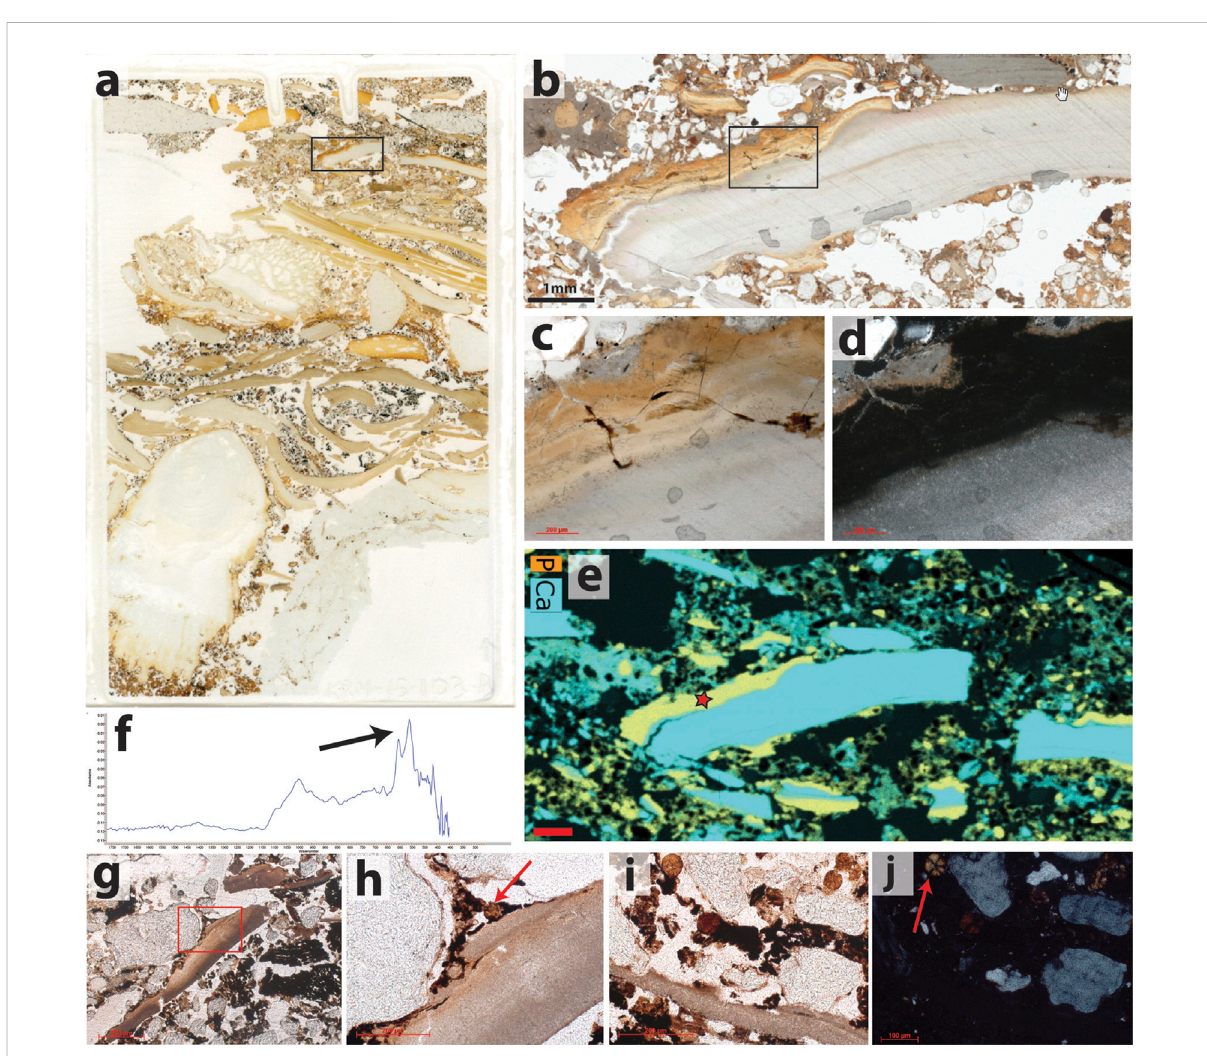
FIGURE 6 Phosphate-induced diagenesis of shell in Cave 2. (A) Flatbed incident light scan of a thin section from the preserved HP shell midden in Cave 2. Two distinct layers of shell are visible here, approximately 2 cm in thickness each. The lower shell layer is well-preserved and is composed of > 50% shell. The upper shell layer is more compressed, and has been impacted by post-depositional phosphatization. The box indicates the location of the photograph in (B) . (B) Detail of an altered shell fragment. PPL. The box indicates the location of the photographs in (C,D) . (C) Under PPL, the alteration zone is yellow. (D) Under XPL, the alteration zone is isotropic. (E) Distribution map of the elements Ca and P. The alteration zone contains both elements. The location of the μ FTIR measurement in (F) is indicated by the star. The scale bar is 1 mm. (F) μ FTIR spectrum collected directly off the thin section using a germanium ATR objective. The arrow indicates the position of the doublet at 605 and 565 cm − 1 that is characteristic of hydroxyapatite. (G) Theonlyshellpresentinthesamplefromtheeasternsideofthechamberisbrokenintomultiplefragments,butretainsitscolorin PPL. The matrix is rich in micro-charcoal. (H) Detail of the area indicated by the red box in (G) . The original fabric of the shell is preserved. The red arrow indicates a leucophosphite crystal aggregate. PPL. (I) One of the shell fragments located just to the right of the image in (G) , with fi ve leucophosphitecrystalaggregatesaboveit.PPL. (J) Sameviewas (I) ,XPL.Theshellfragmentiscompletelyisotropic,butduetothepresenceofsilica rather than hydroxyapatite. The radial crystal habit of the leucophosphite is visible here, with the well-developed extinction cross in one aggregate indicated with the